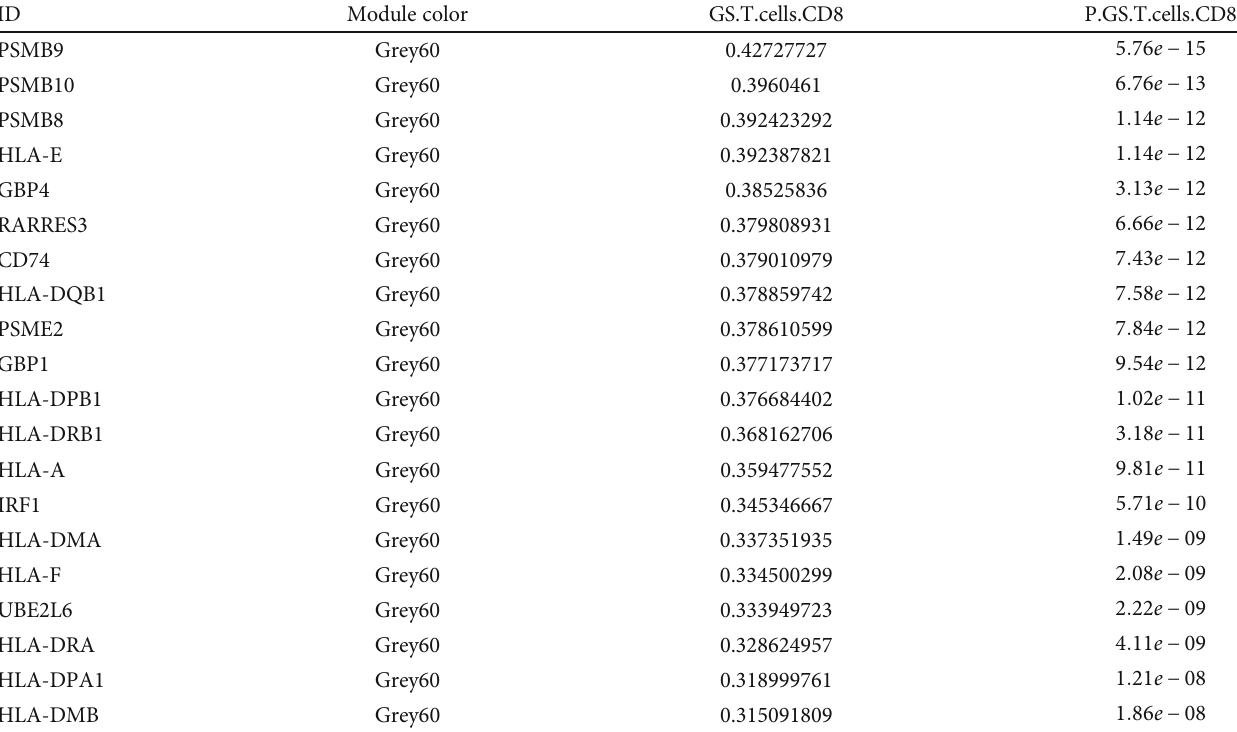
Table 1: The module and gene signi fi cance for CD8+ T cell-related genes in the grey60